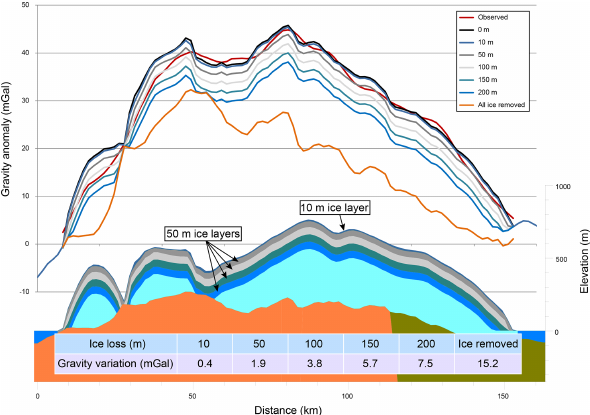
Figure 8. Predicted gravity signature variations with ice loss. The gravity response is calculated using, as the initial state, the 2-D forward model from profile A with the currently known ice thick- ness. Uniform layers of ice with thicknesses of 10, 50, 100, 150 and 200m are removed from the model. The first 10m layer of ice loss yields a gravity anomaly of approximately 0.5mGal. Significant ice loss is detectable from long-term